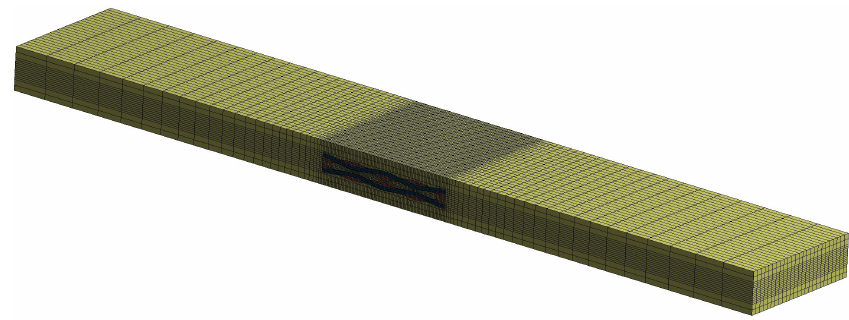
Figure 5. Finite element model of the DCB test specimen.